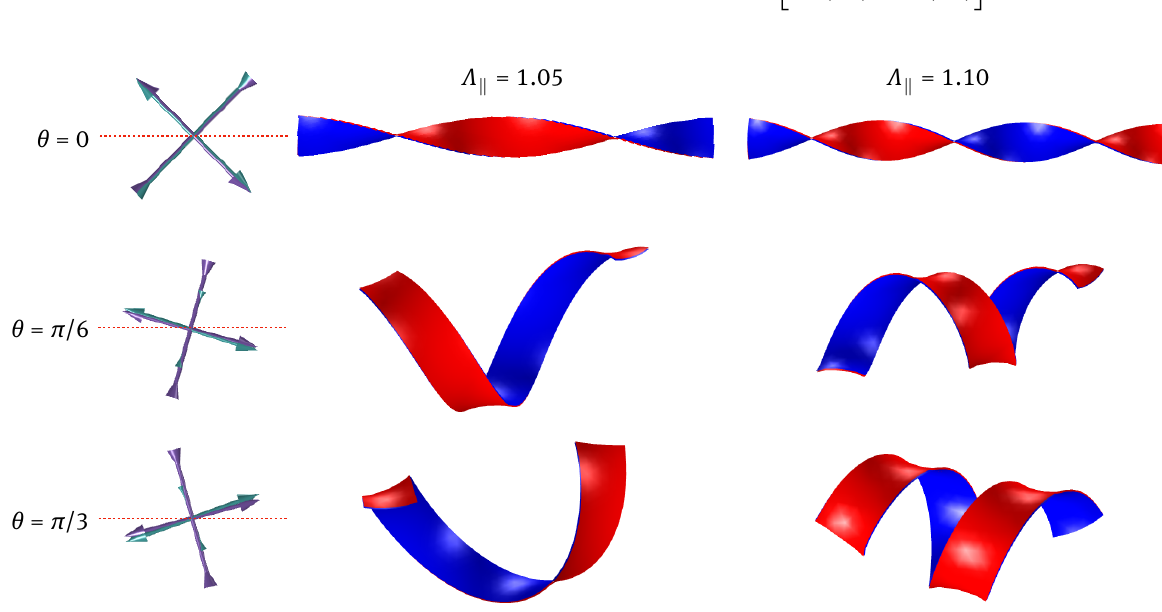
Figure 9: Twist of a flat shell. Each row shows, from left to right: 1) the eigenvectors of B y (green) and B o (violet) against the axis of the reference domain (red, dashed line); 2) The actual configuration for Λ = 1.05 ; 3) The actual configuration for Λ = 1.10 . To highlight the ribbon-like shape, the two sides of the actual shape have different colors (blue and red). The eigenvectors correspond to Λ = 1.10 ;